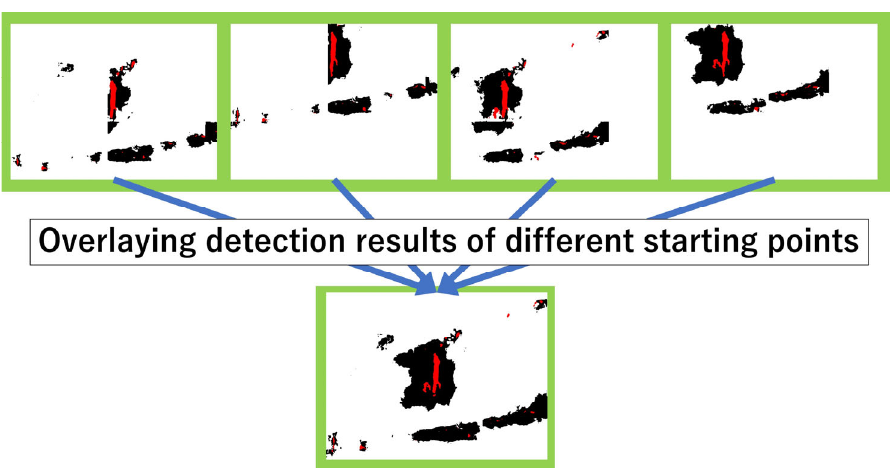
Figure 9. Overlay image of detection results for each division starting point.